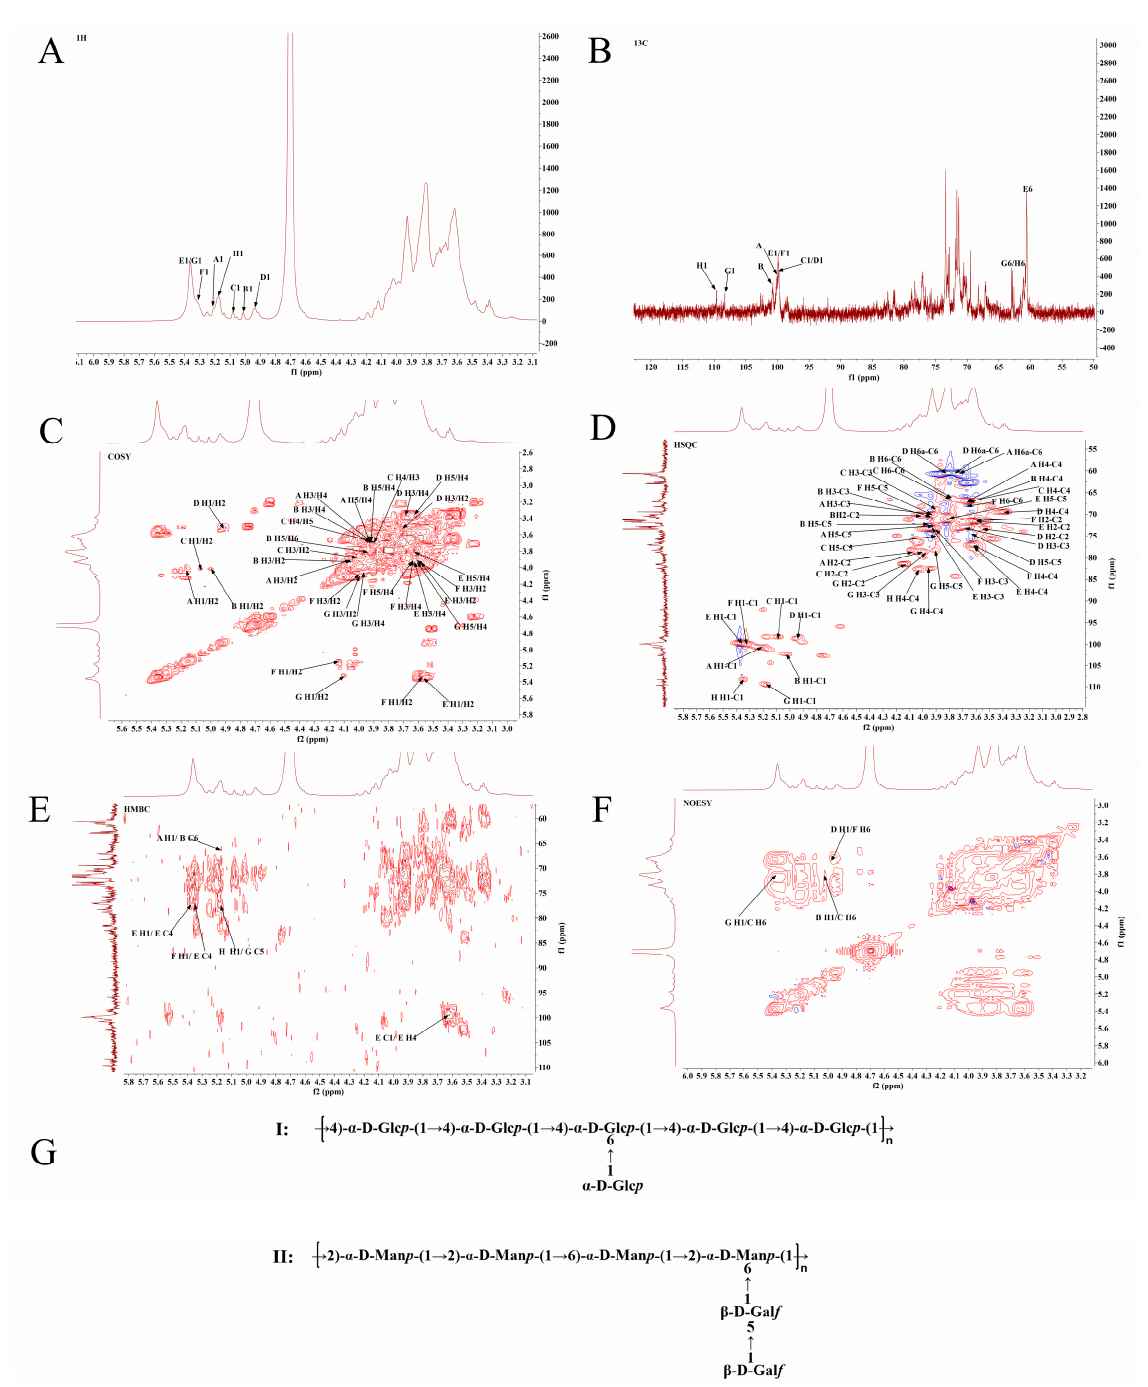
Figure 4. NMR spectra and proposed structures of MSP1-2. ( A ) 1 H NMR, ( B ) 13 C NMR, ( C ) COSY, ( D ) HSQC, ( E ) HMBC, and ( F ) NOESY; ( G ) representation of possible structures of MSP1-2, type I: galactomannan; type II: